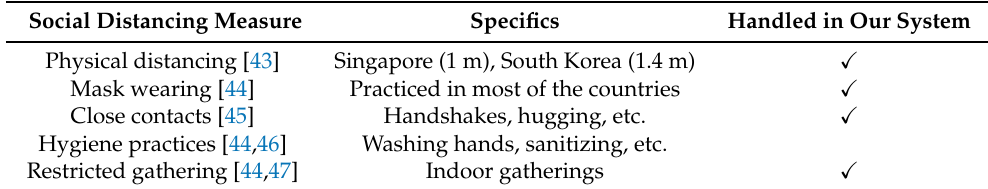
Table 1. Different social distancing measures and the handling availability in our proposed system. Social Distancing